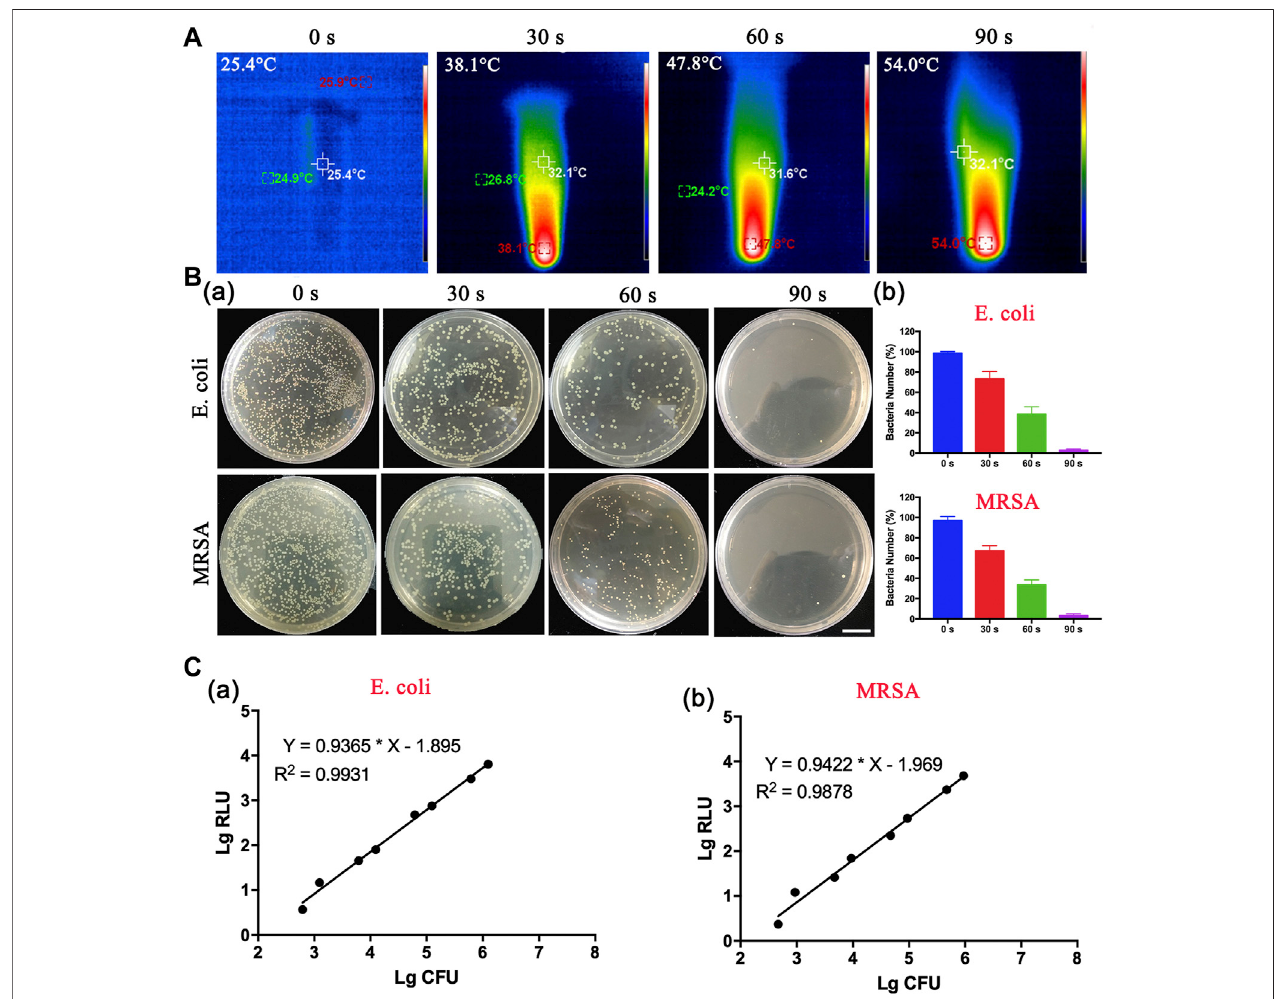
FIGURE 3 | In vitro thermogenesis and antibacterial function of sulfo-DBCO-ICG. (A) Detection of photothermal properties of DBCO-ICG irradiated by 808 nm laser. (B) The pyrolysis of bacteria under different irradiation times. (a) The colony growth of E. coli and MRSA on the after 808 nm NIR. (b) The survival rate of bacteria after E. coli and MRSA were irradiated by 808 nm NIR. (C) Correlation between RLU and CFU of E. coli (a) and MRSA (b) in vitro .